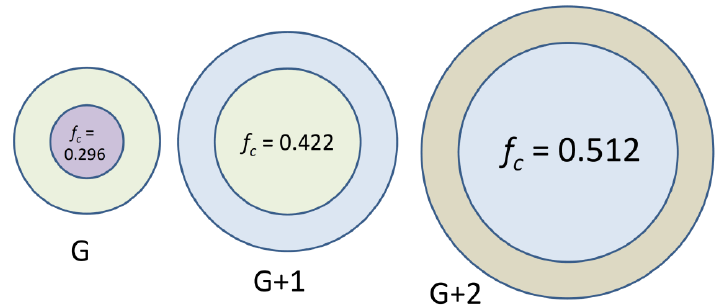
Figure 1. Schematic representation of the diffuse layer growth model for arborescent polymers. The volume fraction of inaccessible (core) material in the molecules, for a core of initial radius R = 2 onto which layers of thickness d = 1 are added, is represented by f